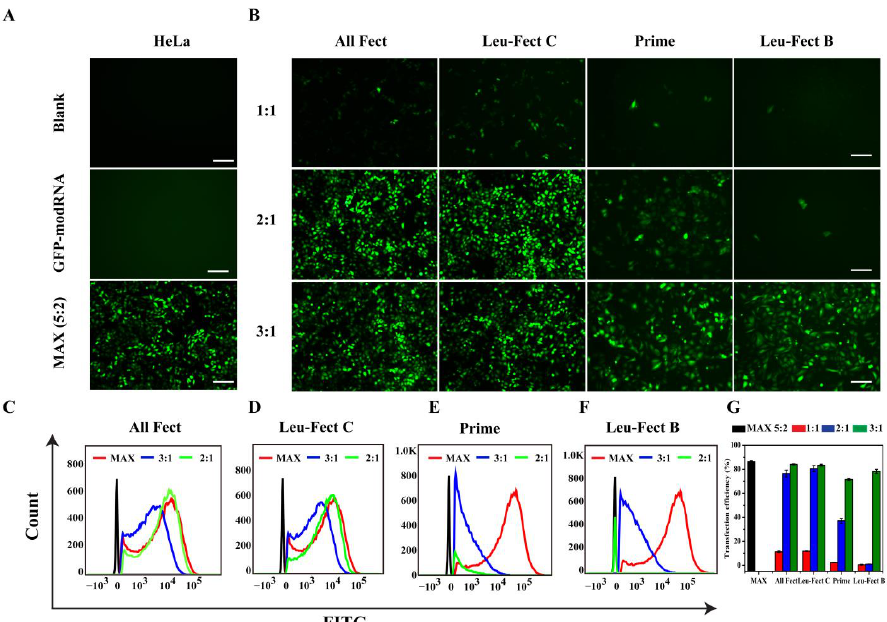
Figure 2. Screening of polymeric vectors in HeLa cells. ( A ) GFP modRNA transfection by MessengerMAX reagent at 5:2 ratio and naked modRNA as a control group. ( B ) GFP modRNA transfection by the polymeric vectors at different ratios. The scale bars in ( A , B ) represent 200 μm. ( C – F ) The transfection efficiency was analyzed by flow cytometry. Red represents the transfection efficiency of MessengerMAX at the optimal ratio of 5:2, blue represents the transfection efficiency of the polymer at a ratio of 3:1, and green the transfection efficiency of the polymer at a ratio of 2:1. ( G ) Transfection efficiency statistics for different vectors and modRNA at different mixing ratios. Data represent mean ± SD ( n = 3).